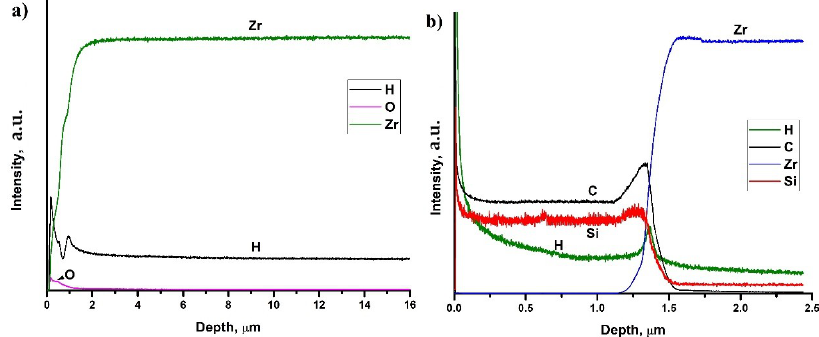
Figure 6. Depth distribution of elements in hydrogenated Zr-1Nb ( a ) and SiC-coated Zr-1Nb alloy ( b ).